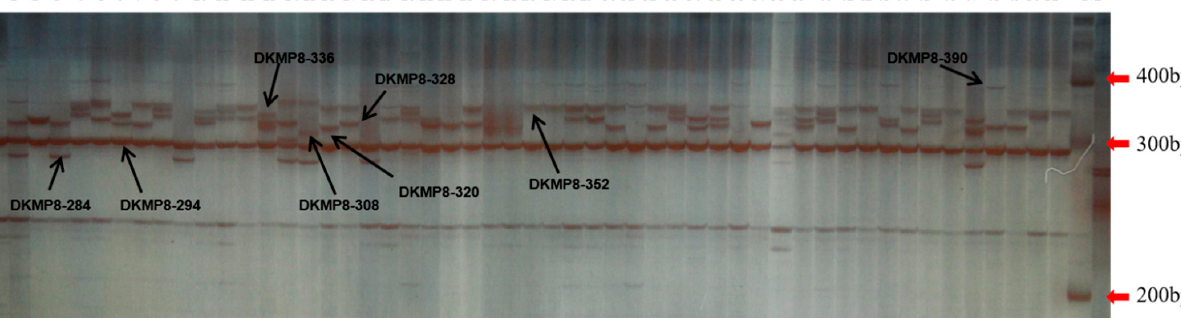
Figure 1. Polyacrylamide gel obtained in simple sequence repeat (SSR) marker A1. The number at the top of the figure represents the sample order; the number beside the right of the figure represents the size of DNA marker; each locus of the DKMP8 SSR marker is labeled in the figure with the black arrow. Sample genotypic data of DKMP8 were created based on the presence (1) or absence (0) of each loci (e.g., in sample 48, the genotypic data of DKMP8 marker are DKMP8 ‐ 284 (0), DKMP8 ‐ 294(1), DKMP8 ‐ 308(0), DKMP8 ‐ 320(0), DKMP8 ‐ 328(1), DKMP8 ‐ 336(0), DKMP8 ‐ 352(0), DKMP8 ‐ 390(1).